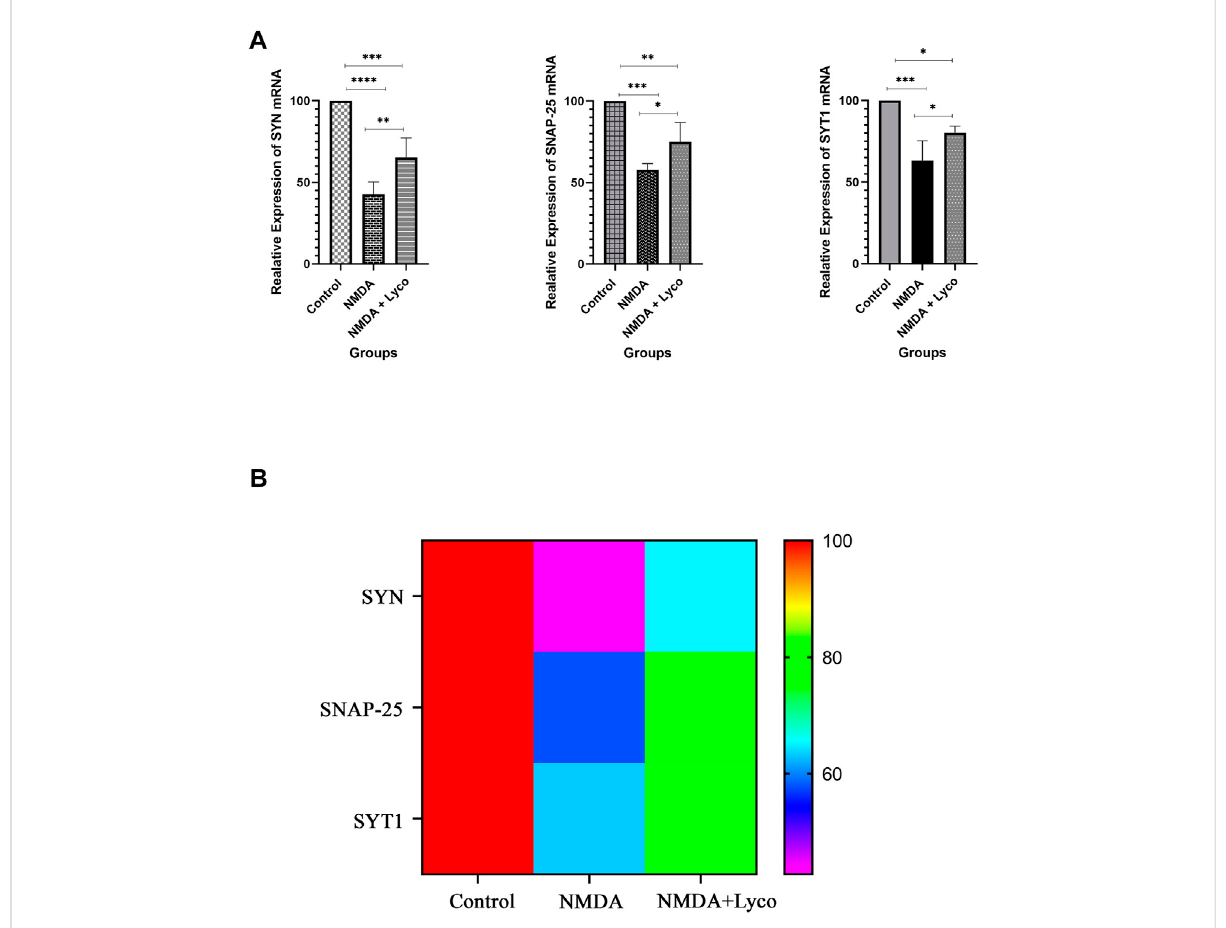
The Quantitative Real-Time PCR (A) The effect of treatment with OLG1e on the hippocampal SYN, SNAP-25, and SYT1 mRNA levels. The data are shown as means± SEM of six rats per group. (* p < 0.05 and ** p < 0.01 and *** p < 0.001 and **** p < 0.0001) (B) Heat map for SYN, SNAP-25, and SYT1 mRNA levels (Two-way